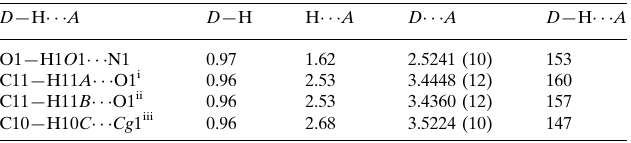
Hydrogen-bond geometry (A˚ , (cid:2)